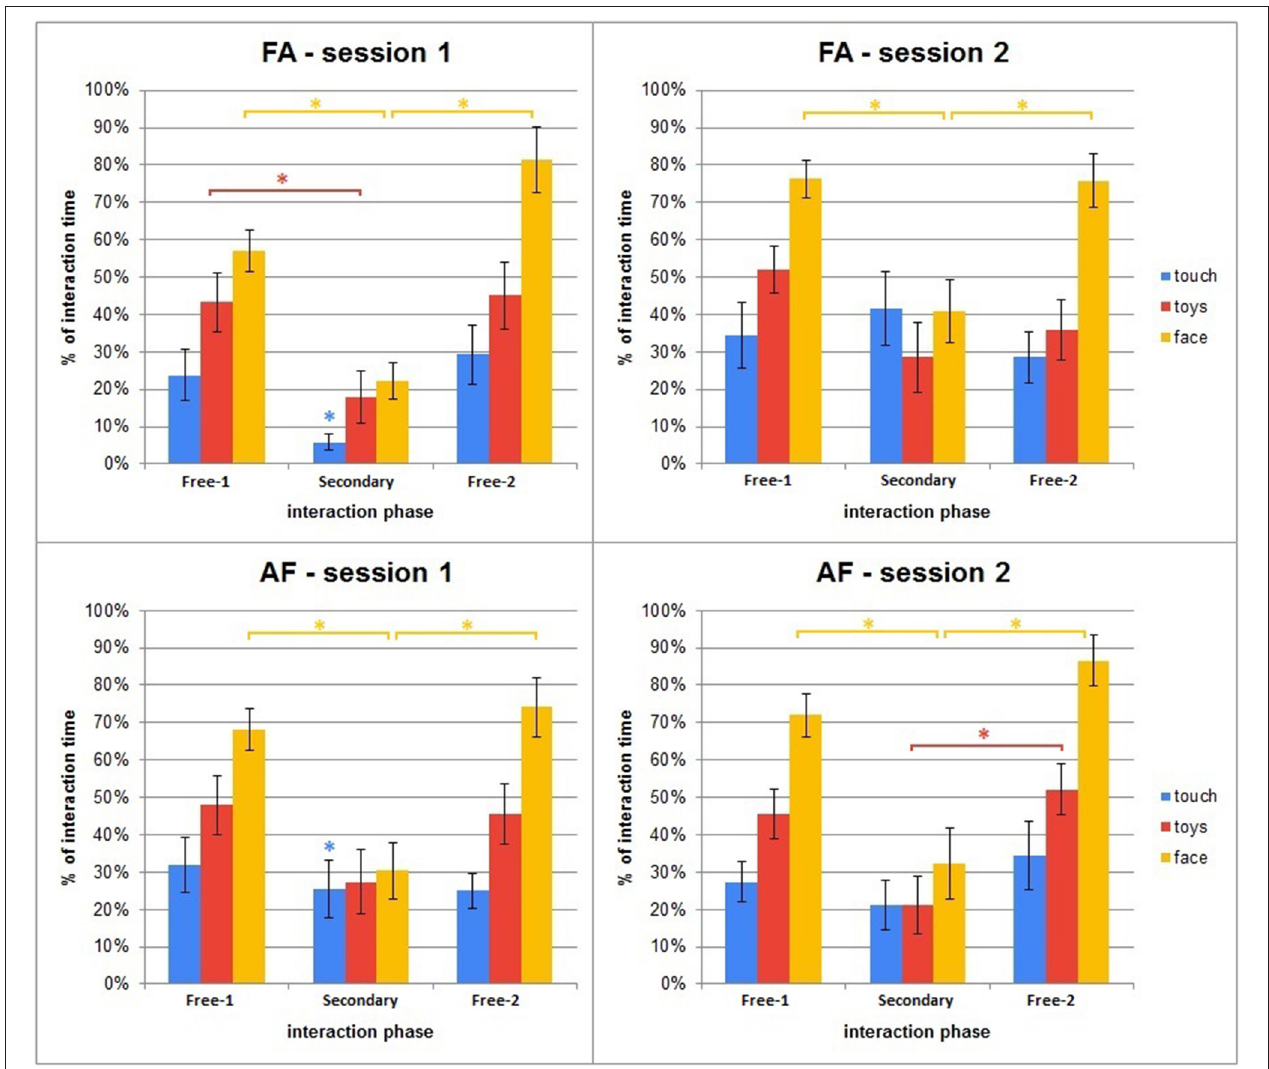
FIGURE 12 | Averages of the perceived stimuli in different modalities during the interaction, shown across phases and sessions. Error bars represent standard error. Asterisks indicate significant